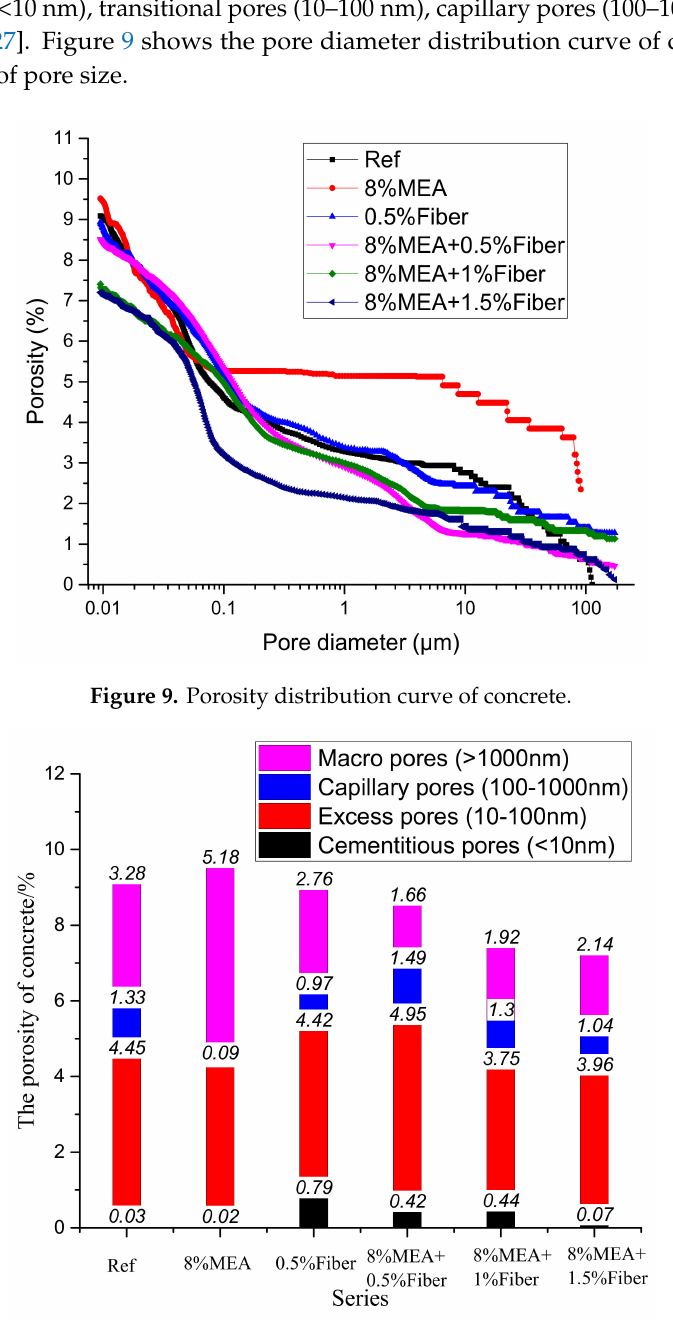
Figure 10. Statistics of concrete pore